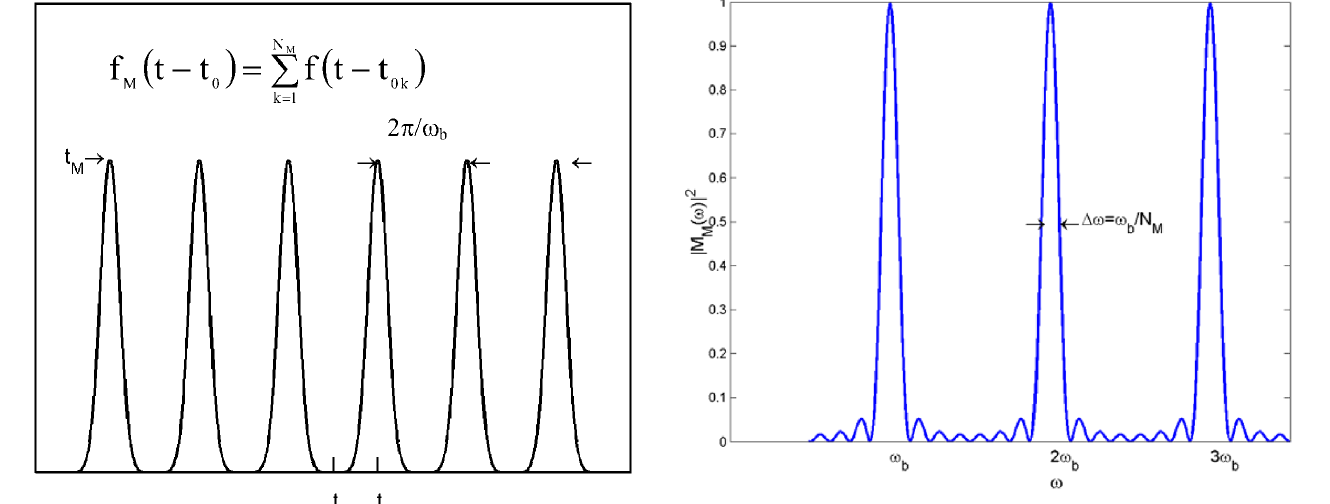
microbunches at periodicity 2 (cid:6)=! M